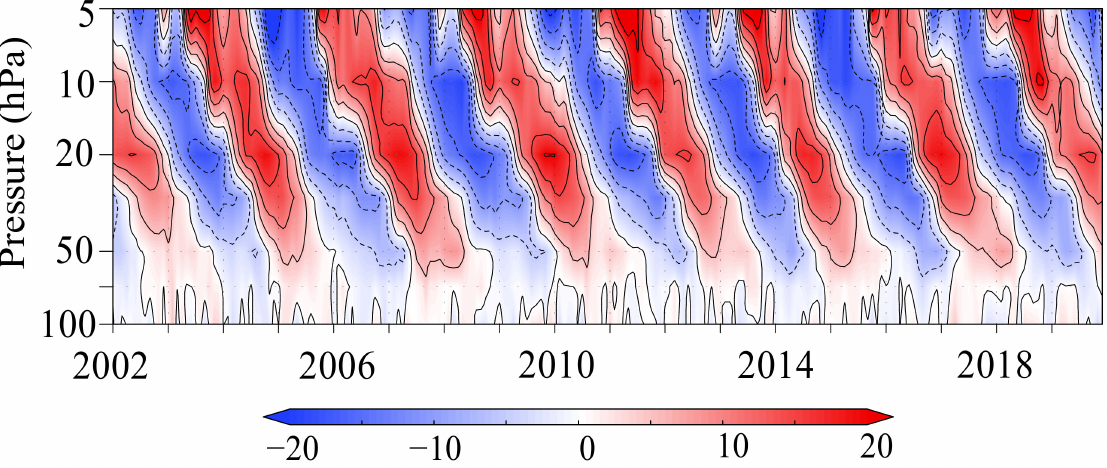
Figure 1. Time–height cross-section of zonal–mean-zonal wind anomalies (ms − 1 ) averaged between 10 ◦ S and 10 ◦ N in the tropical stratosphere (100–5 hPa) for the control run from 2002 to 2019. Contours interval is 5 ms − 1